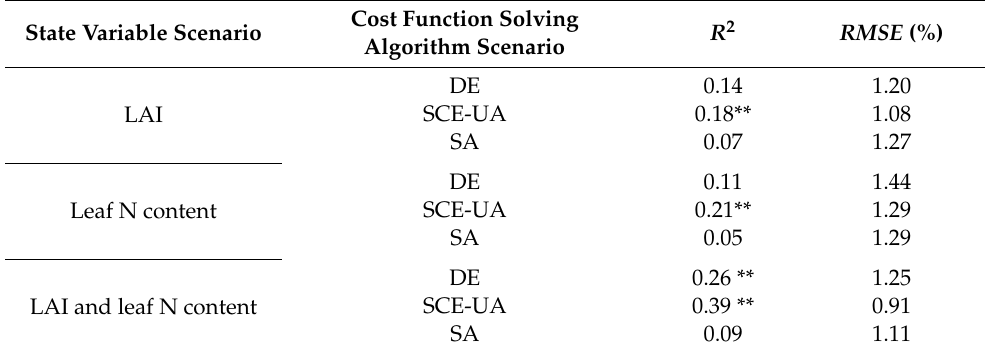
Table 5. Data assimilation results for GPC estimation under di ff erent state variable and cost function solving algorithm scenarios.